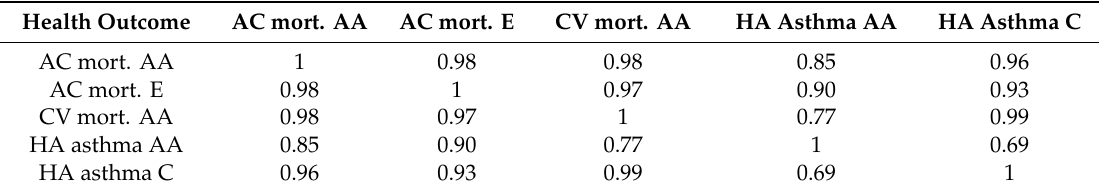
Table 3. Correlation matrix with R-values for di ff erent pairs of AQHI-indexes, calculated in Stockholm for NO 2 , O 3 , and PM 10 based on the daily risk increases during the period of 2015–2017. The abbreviations mean the following: AA = all ages, AC = all cause, C = children, CV = cardiovascular, E = elderly, HA = hospital admissions.